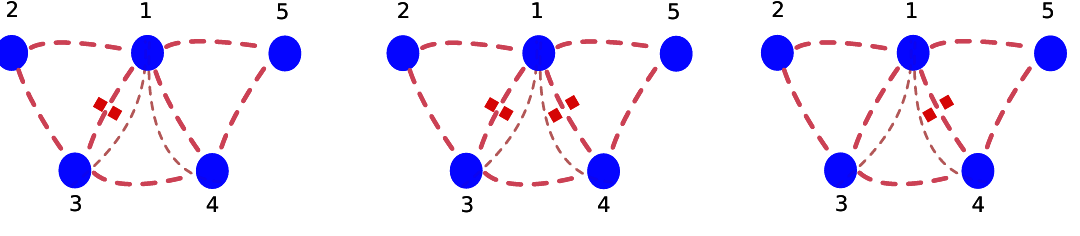
Figure 6 . The three O ( g 2 ) gluing processes on the front of (cid:12)gure